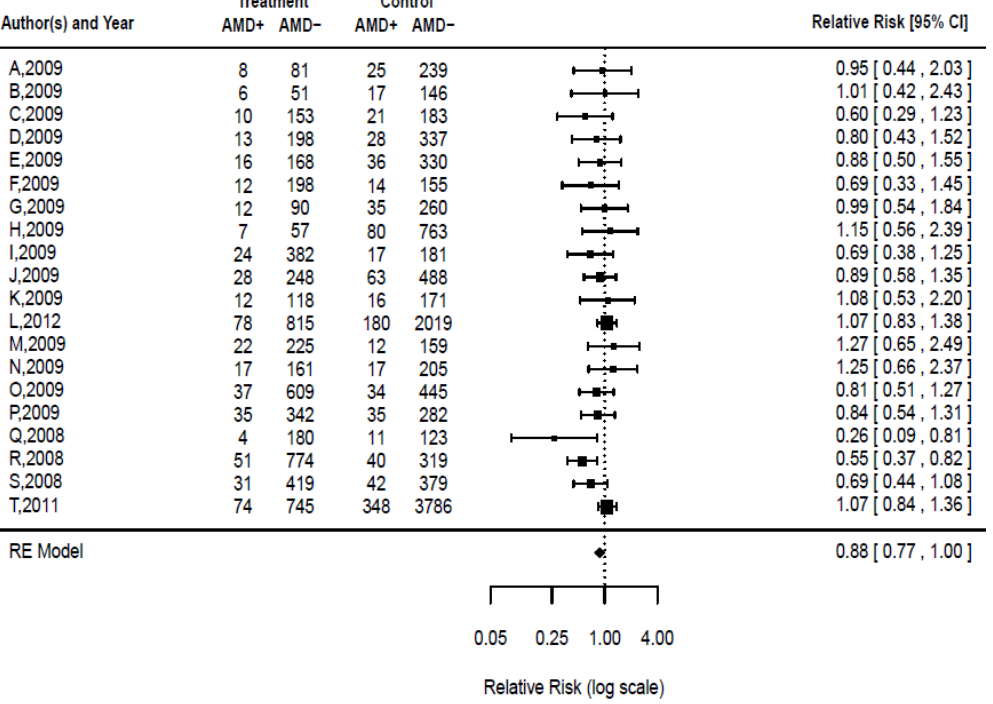
Figure 3. Forest plot for random effects